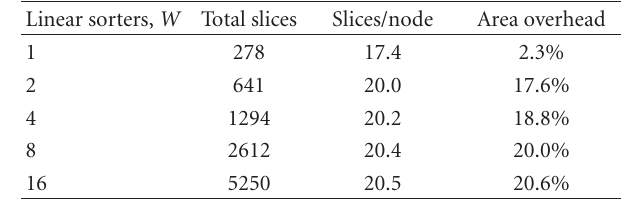
Table 5: ILS FPGA